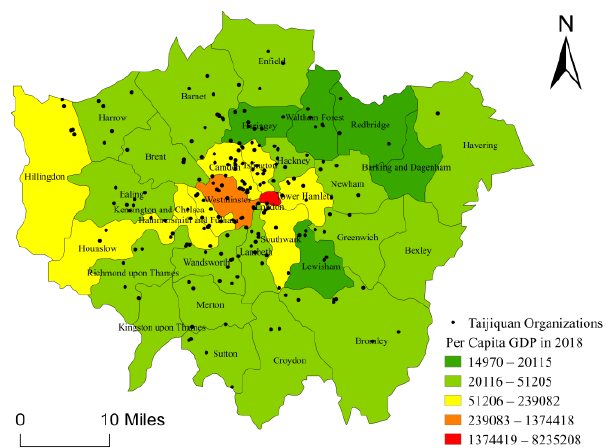
Figure 9. Per Capita GDP Distribution Map of Boroughs in London